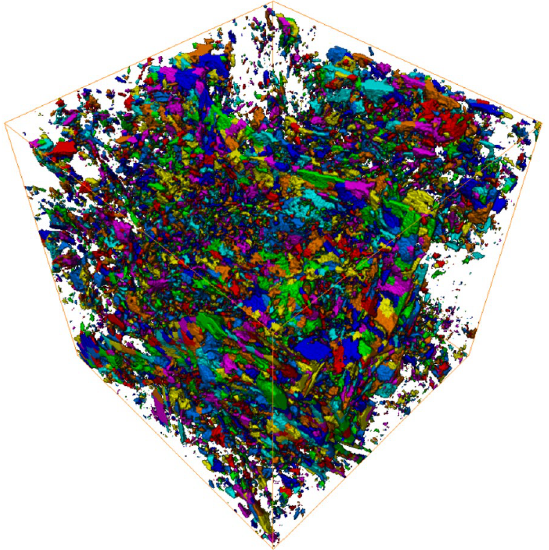
Figure 2. Visualization of classified pores within the pore-phase 3D